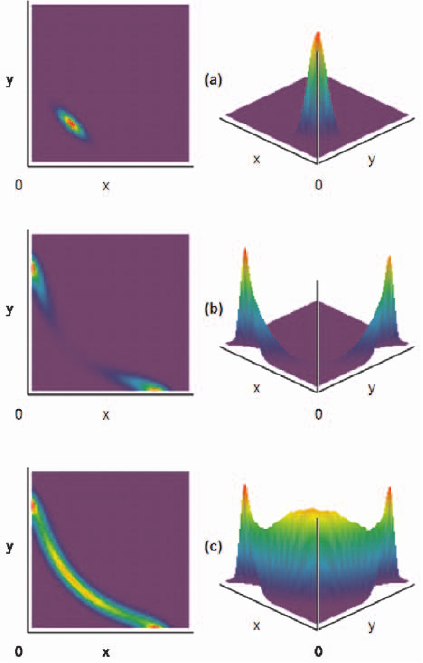
Figure 3.The results of the stochastic simulation of the systemfor three parameter configurations. (a) b . c , (b) c . b and (c) c=b . (see text for details). Colors (or elevation, respectively) represent the steady state probability distribution (cold-to-warm colors for low-to-high probability for finding the circuit at a given position in the xy -phase plane).